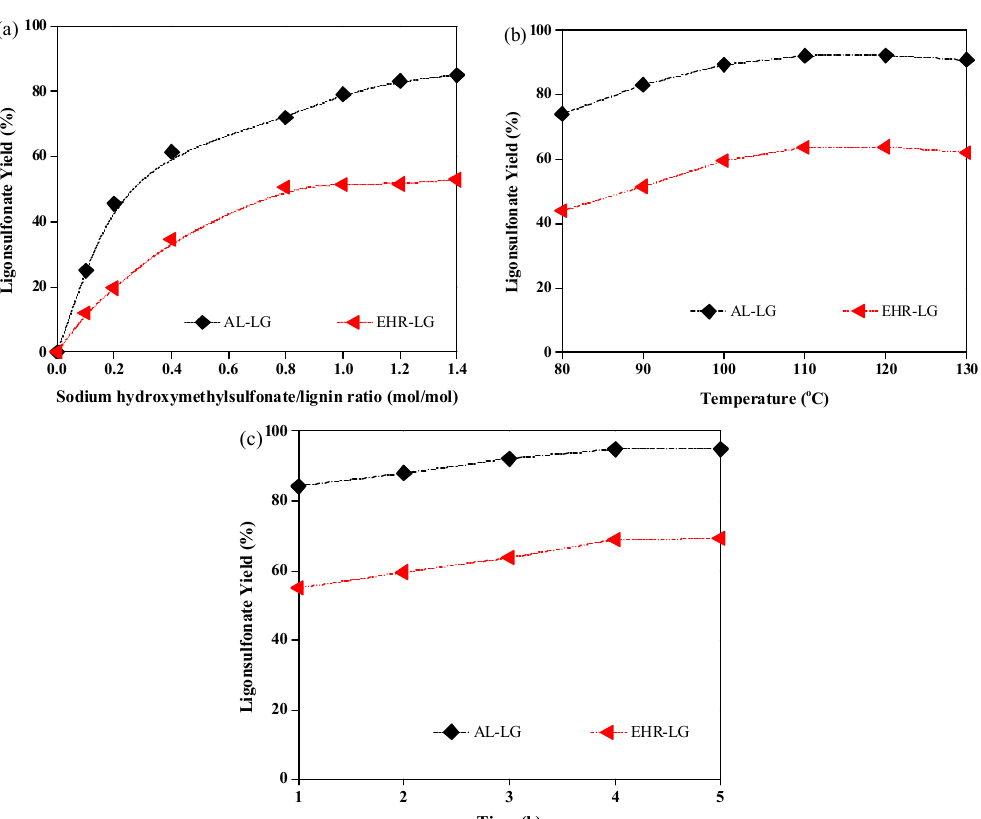
Figure 1. The effect of CH 2 OHSO 3 Na/lignin ratio ( a ), temperature ( b ), and reaction time ( c ) on the lignosulfonate yields of lignosulfonate (LG) from alkaline lignin (AL) and enzymatic hydrolysis residue (EHR), termed as AL-LG and EHR-LG, respectively